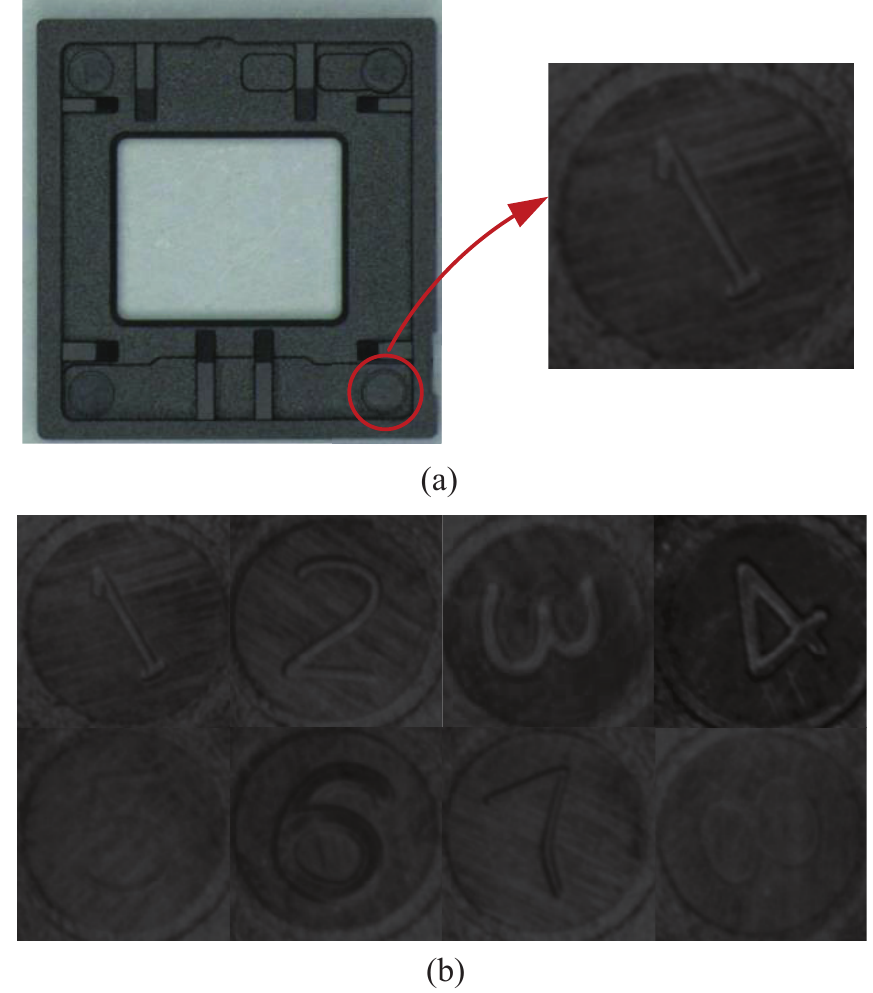
Figure 5. The number label on the workpiece and its location. ( a ) The industrial electronic equip- ment parts and the captured digital number. ( b ) The Digital number on some industrial electronic equipment parts, from 1 to 8, respectively representing the corresponding mold number of differ- ent